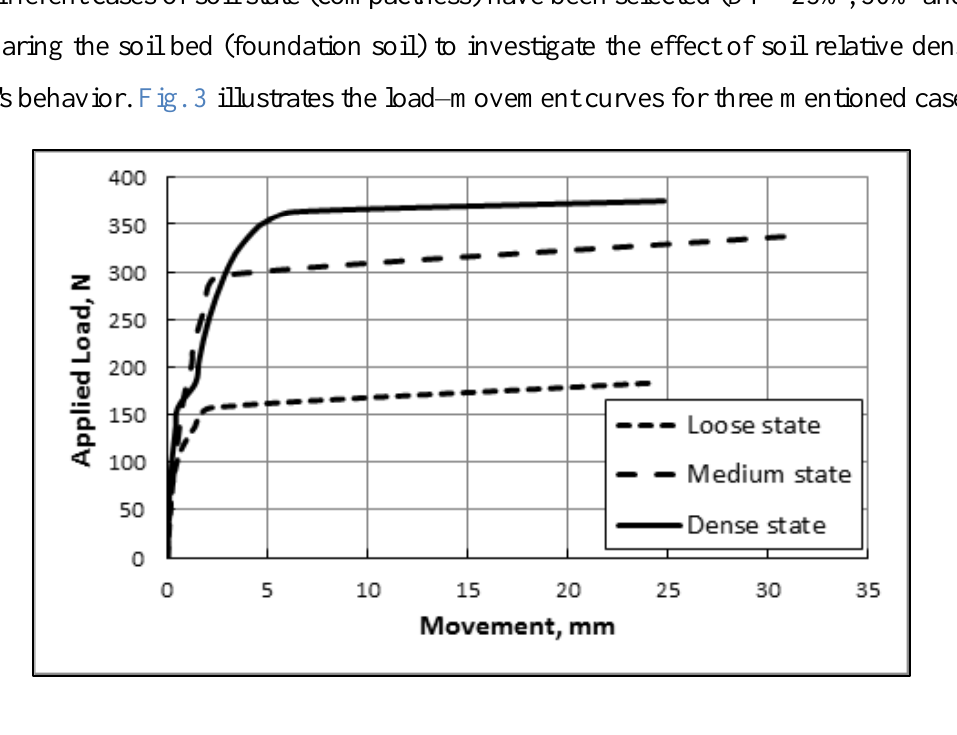
Fig. 3. Loading-movement curves for different relative densities of the foundation